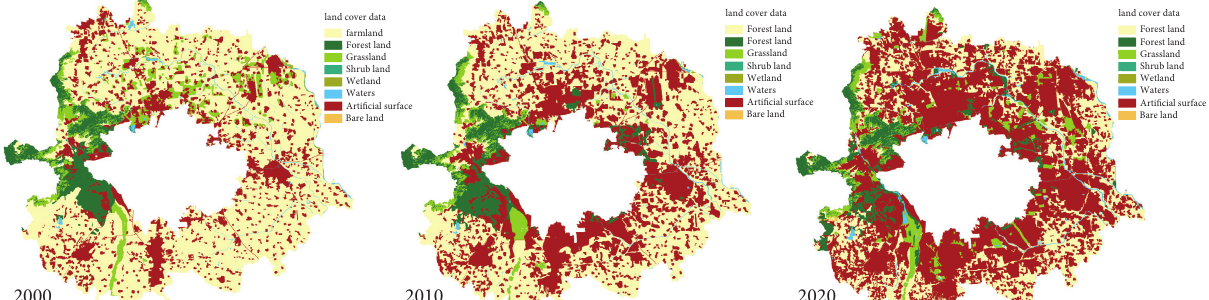
Figure 4: Land cover change of the second green isolation area (2000–2020).